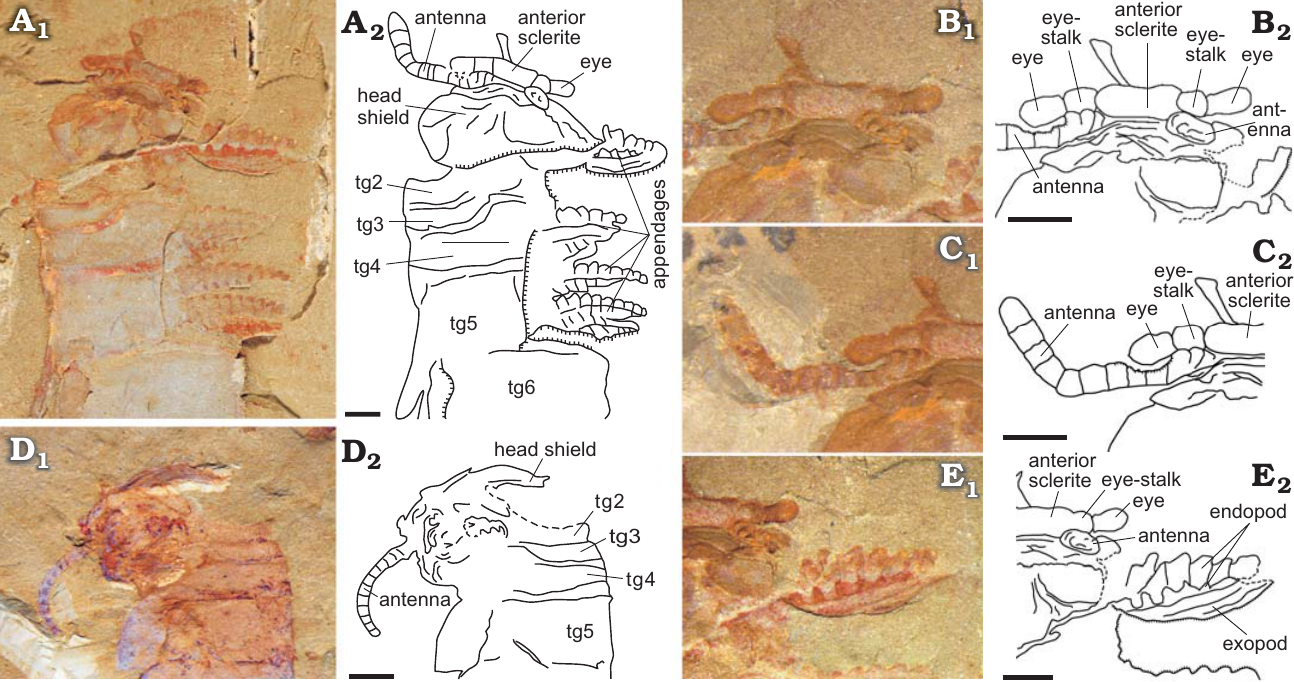
Fig. 2. Fuxianhuiid euarthropod Guangweicaris from Guanshan Biota, Cambrian Series 2, Stage 4, Yunnan, China. A . ELI-LBSG-0046A, showing the whole head part and the pairs of thoracic appendages. B . ELI-LBSG-0046A, showing the ocular segment and the stalked eyes. C . ELI-LBSG-0046A, show- ing the stout antennulae. D . ELI-LBSG0006B, cephalon, showing the cephalic shield and the stout antennulae. E . ELI-LBSG-0046A, showing the two pairs of cephalic appendages. All in lateral view. Abbreviations: tg, tergite (tg1–tg3, anterior reduced segments; tg4–tg6, thoracic tergites). A –D , explanatory drawings. Scale bars 2 A 2 2